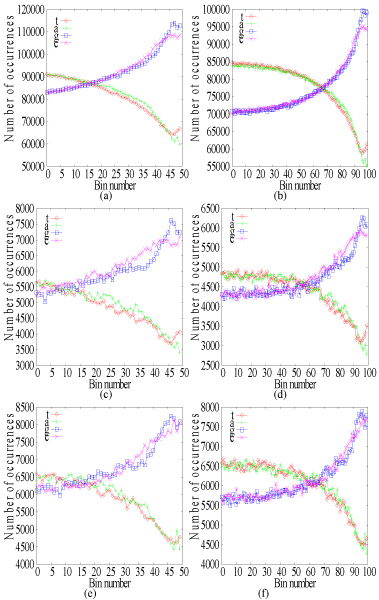
Frequency distribution of single nucleotides (A, T, G, C) on six data sets. Figure 1 shows the frequency of the four single nucleotides (A, T, G, C) on six different data sets: (a)S1000. (b)S2000 (c)Shk1000 (d)Shk2000 (e)Sts1000 and (f)Sts2000. In each figure, x axis is the bin number and y axis is the number of occurrences of a single nucleotide in a bin. G/C content is shown to be much higher than A/T content at the location close to TSSs in all figures. But there is a small increase of A/T content at the location where TATA Box resides(the second closest bin to TSSs). This can help explain why there is a TATA Box in a area where the majority of bases are G and C. At the 5' end of promoters far from TSSs, A/T content is observed to be higher than G/C content. And little difference of frequency of single nucleotides is observed between housekeeping genes and tissue specific genes when comparing Figure 1(c) and Figure 1(e) and comparing Figure 1(d) and Figure 1(f).